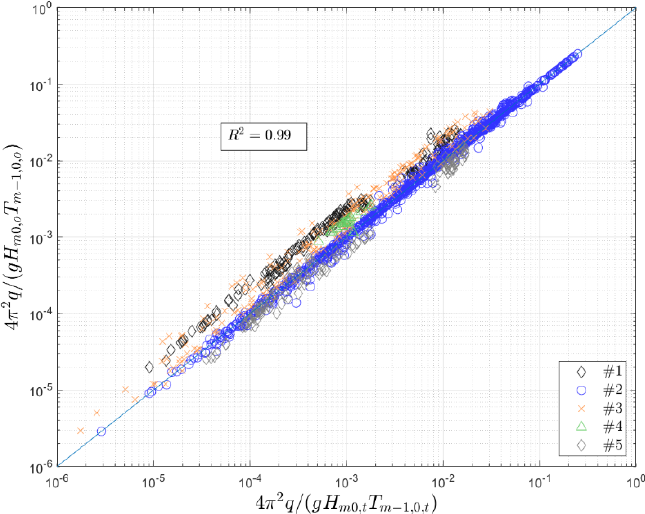
Figure 9. Comparison between the volume flux calculated employing deep-water wave characteristics and local ones.